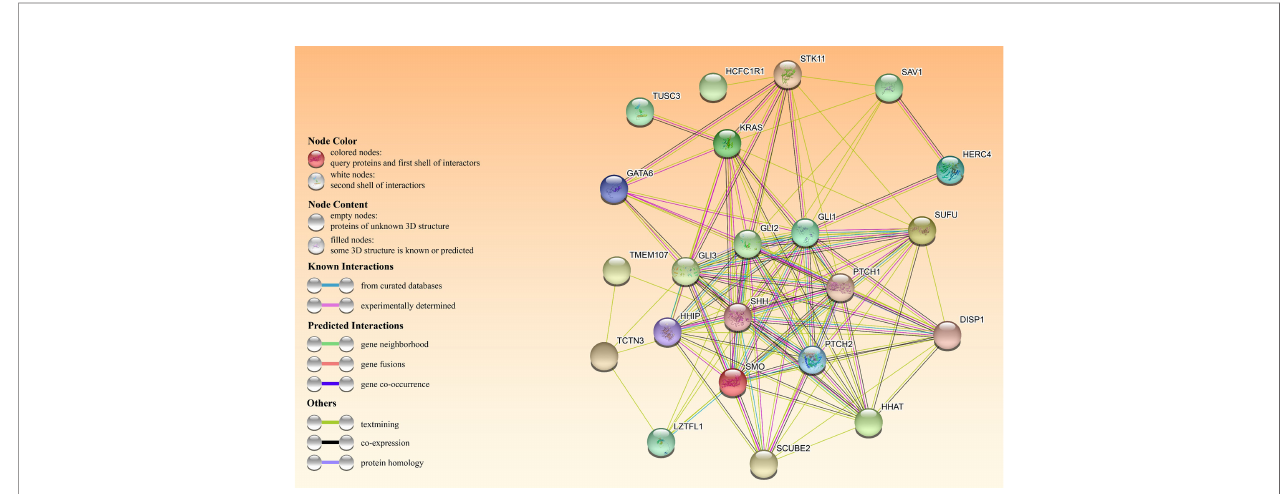
FIGURE 4 | The HH pathway interacts with other oncogenes or tumor suppressors in patients with HH-dependent lung cancer. The interactome in the center was obtained through the STRING